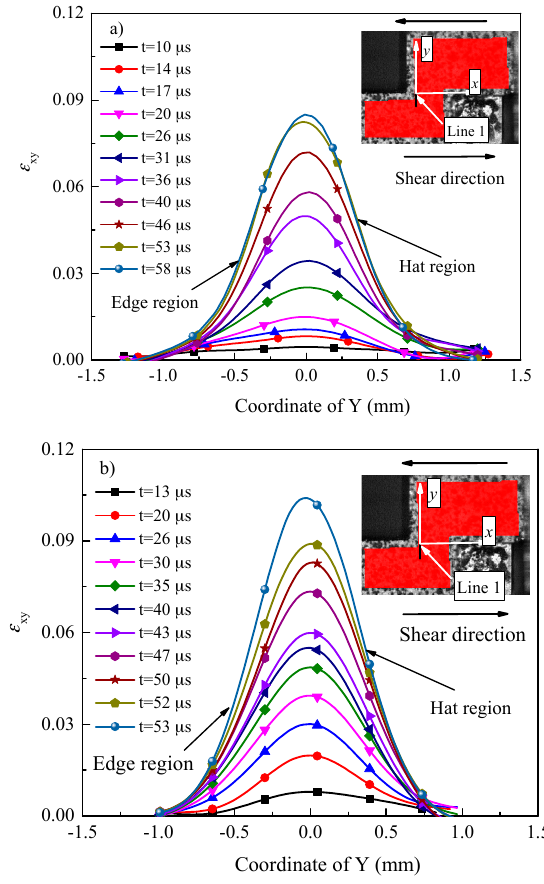
Figure 8. Distribution of shear strain at line 1 at different loading time for ( a ) Ti-64 alloy deformed at 9.2 m/s; and ( b ) Ti-55511 alloy deformed at 9 m/s. The center of shear region is defined as x axis, and y axis is perpendicular to the shear region.